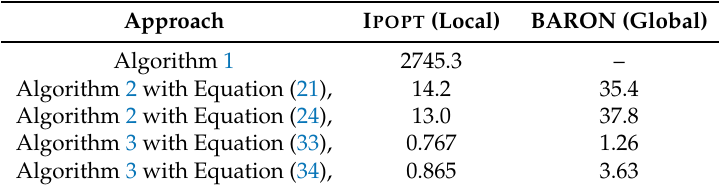
Table 1. Timing results for Case Study 1 (in seconds).